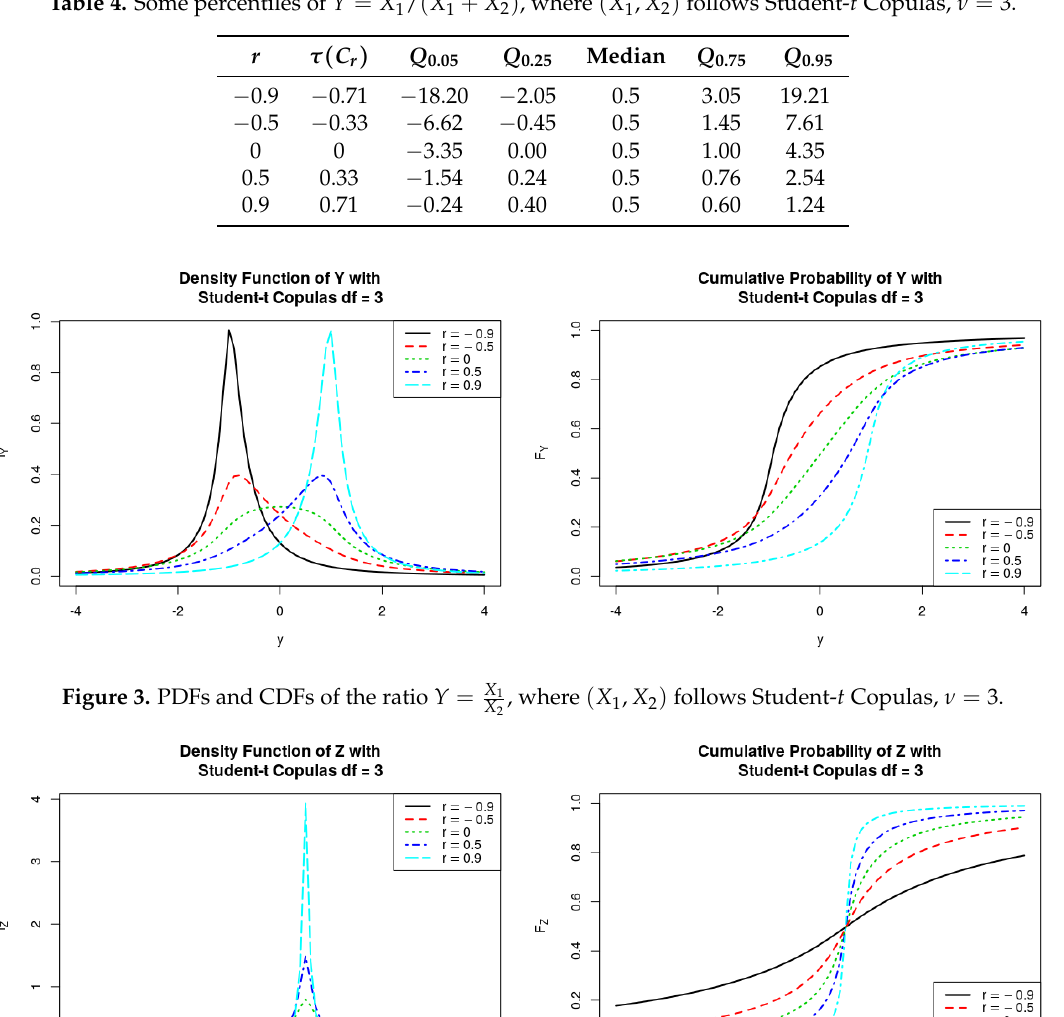
Table 4. Some percentiles of Y = X 1 / ( X 1 + X 2 ) , where ( X 1 , X 2 ) follows Student- t Copulas, ν = 3.